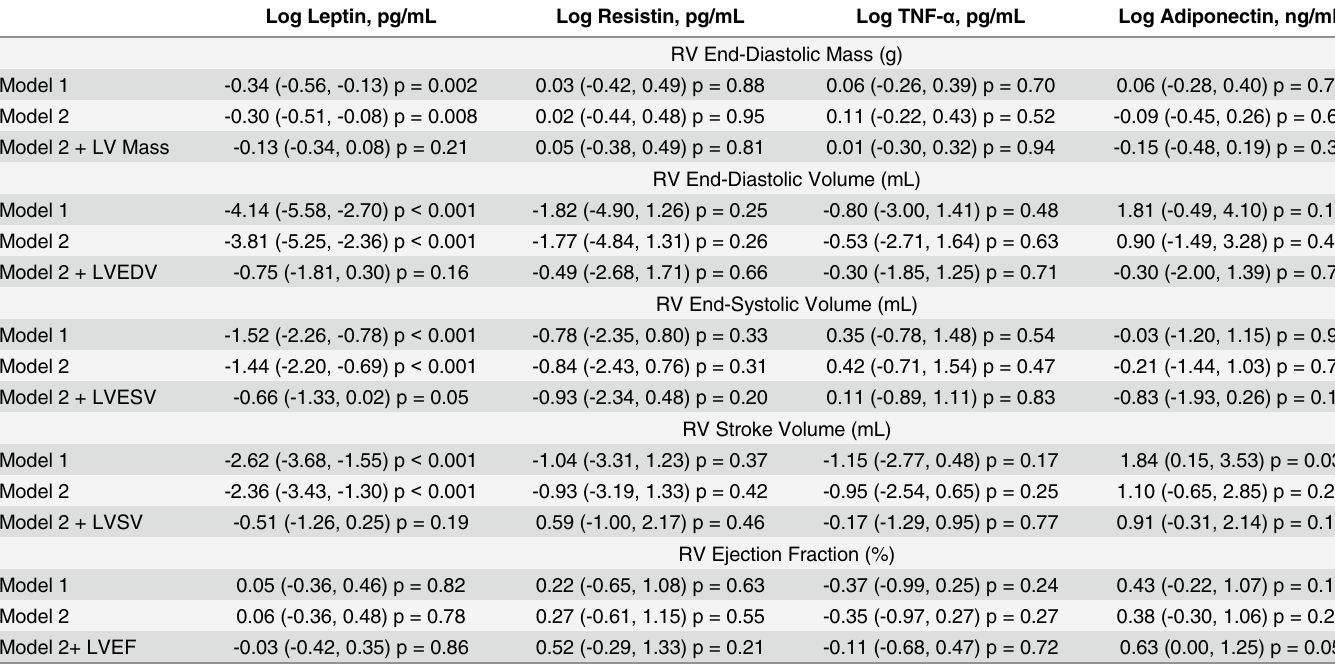
Table 3. Adjusted linear regression coefficients and 95% confidence intervals of the association between adipokines and right ventricular struc- ture and function. Model 1: Adjusted for age, gender, race, height and weight. Model 2: Model 1 + education, systolic and diastolic blood pressure, total & HDL cholesterol, triglycerides, current smoking status and pack years, diabetes, waist & hip circumference, glucose, and currently taking statins or hyperten- sion medication. Model 3: Model 2 + respective LV measure. Abbreviations: RV = right ventricle, LV = left ventricle, LVEDV = left ventricular end-diastolic vol- ume, LVESV = left ventricular end-systolic volume, LVEF = left ventricular ejection fraction, LVSV = left ventricular stroke volume. Log Leptin, pg/mL